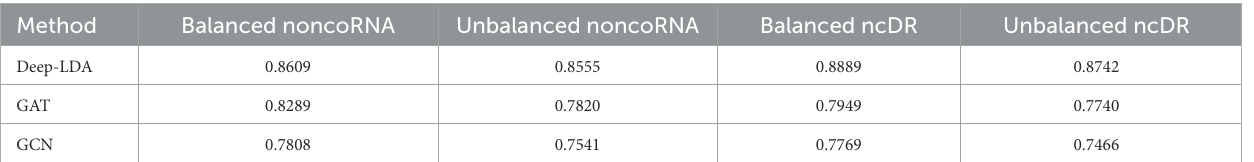
TABLE 3 Comparison of average performance metrics of each module.